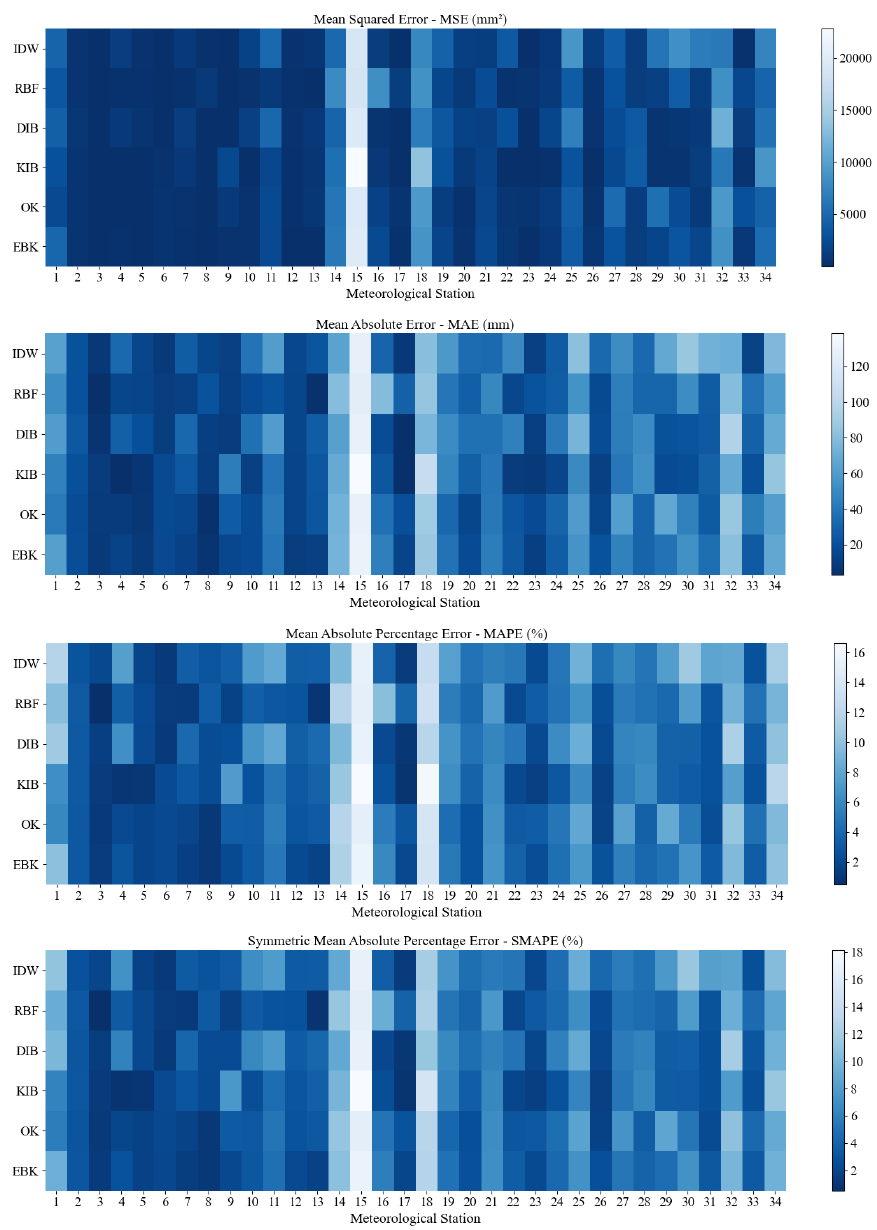
Figure 7. Cross-validation error indicators values (MSE, MAE, MAPE, SMAPE) of six interpolation methods based on integrated multiple rainfall